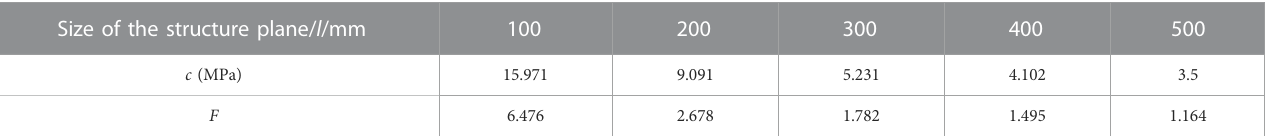
TABLE 5 Values of c and f .